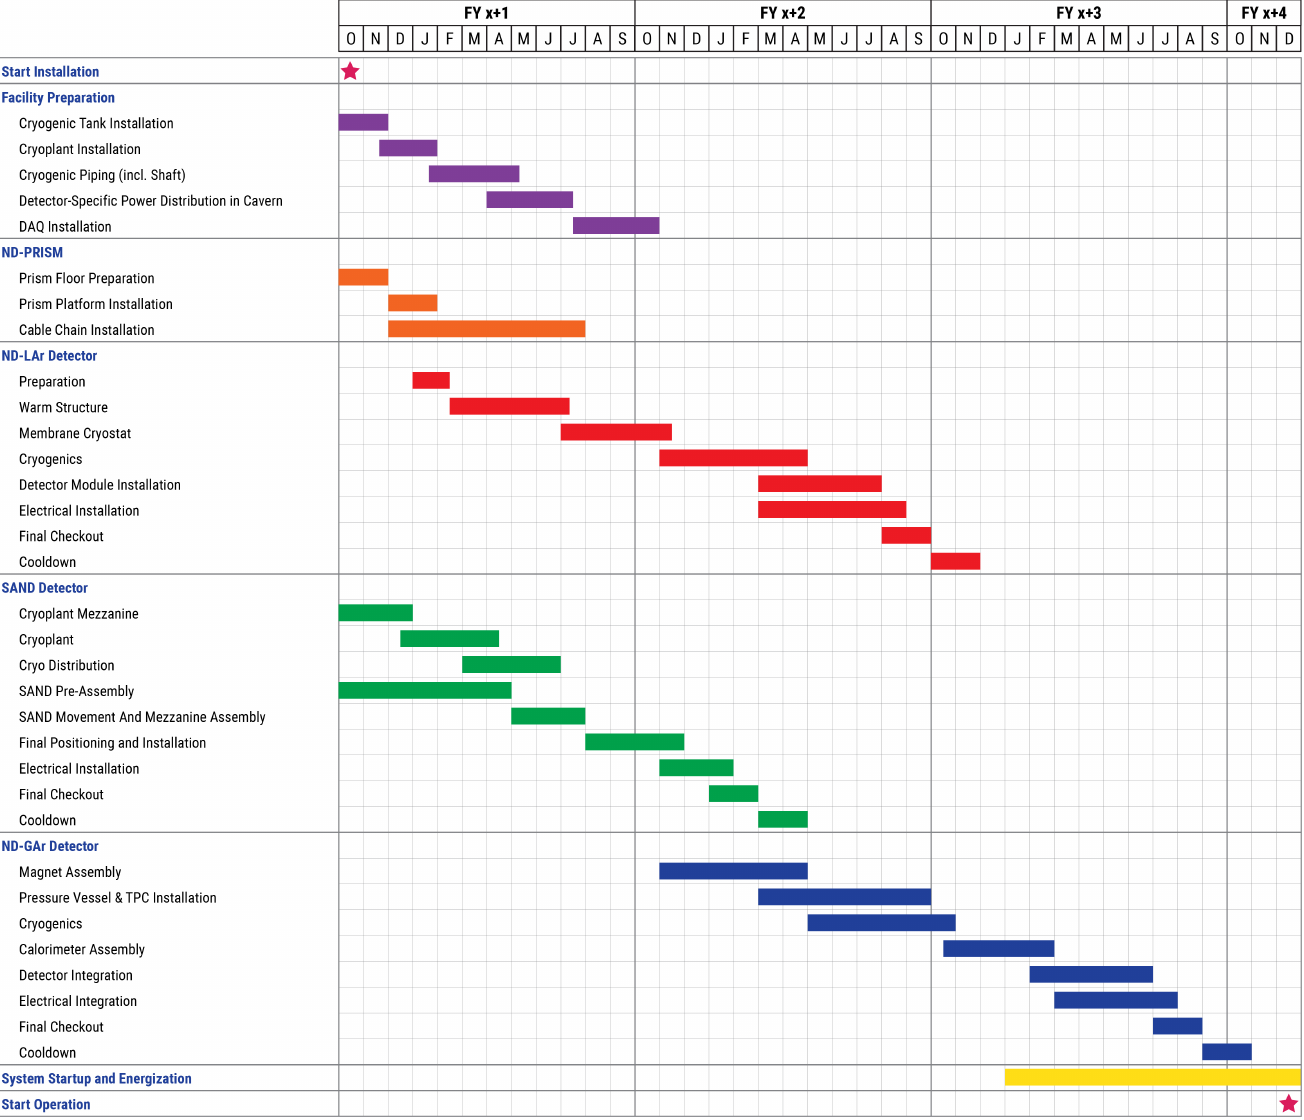
Figure 184. A conceptual DUNE ND Facility installation schedule. Installation will commence (“FY x + 1” in the displayed schedule) once cavern construction has been completed and authorization to use the ND facility has been granted. Assembly of the full DUNE ND reference design including checkout and transition to operation will require approximately three years to